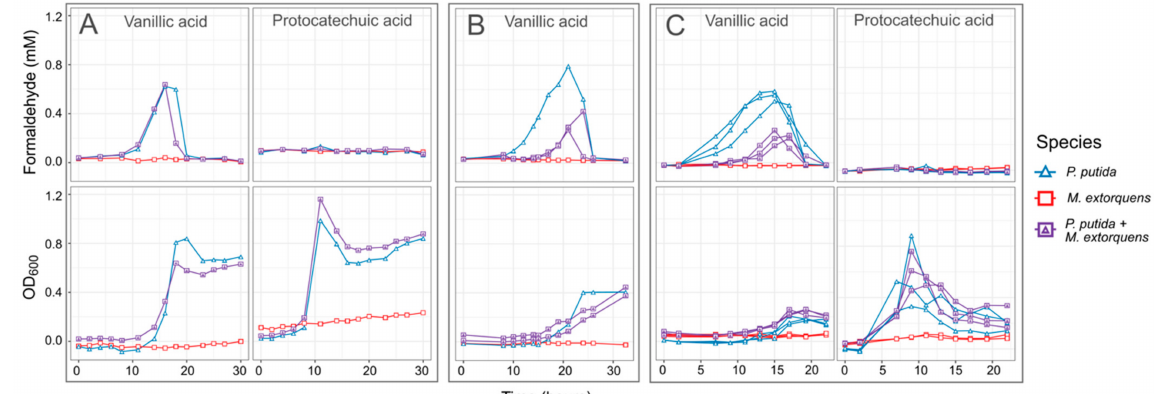
Figure 4. When P. putida grows on vanillic acid as a sole carbon substrate, formaldehyde accumulates in the medium to levels potentially toxic to C. fimi . When grown in coculture with P. putida , M. extorquens reduces formaldehyde accumulation. Shown here are the formaldehyde in the medium (top row) and total growth of the community (bottom row) from three separate experiments in which M. extorquens and P. putida were grown separately or together in minimal medium with vanillic acid as the sole carbon source: ( A , B ) 4 mM vanillic acid or protocatechuic acid; ( C ) 10 mM. Individual lines represent independent culture vessels. As M. extorquens cannot grow on vanillic acid, no activity was observed in the M. extorquens –only cultures. In cultures containing P. putida , formaldehyde was generated on vanillic acid during the exponential growth phase, and the duration and peak of the formaldehyde was lower in cultures containing M. extorquens . The data in panel ( B ) are from a larger experiment testing M. extorquens cultures from different pre-growth conditions and inoculation ratios; full results for that experiment are shown in Figure S4. All data shown here are from cultures initiated in stationary phase, and from M. extorquens pre-grown on